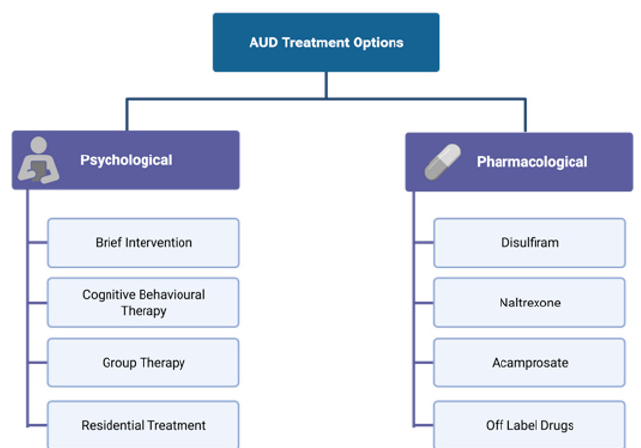
Figure 3. Psychological and pharmacological interventions for the treatment of AUD. AUD treat- ment includes both non-pharmacological (psychological) interventions that vary from individual approaches to extensive in-patient residential treatment, as well as several pharmacological ap- proaches that target some of the neurotransmitter systems affected by alcohol.